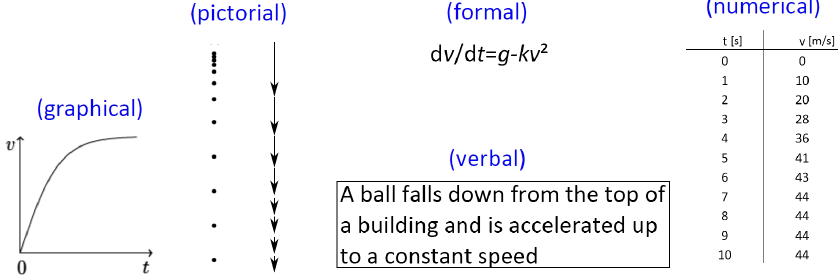
FIG. 1. Coherent representations of an isomorphic kinematics problem: velocity-time graph; strobe picture (the dots record the position at equal time intervals), and vector picture (acceleration or net force vectors); differential equation ( g ¼ Earth ’ s acceleration, k ¼ constant); verbal problem statement and data